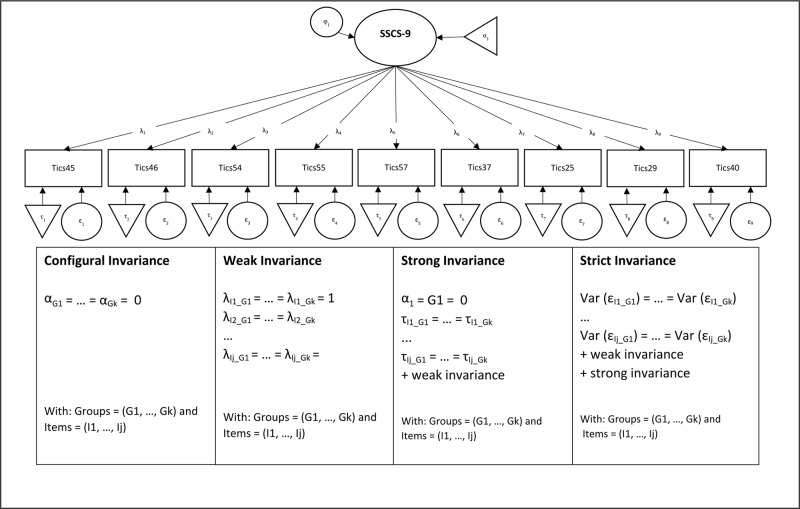
Models relevant for the invariance test.